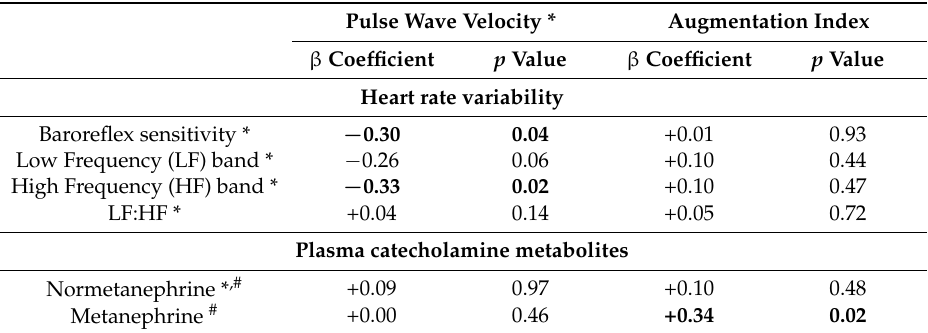
Table 1. Multiple regression analyses of the relationship between measures of autonomic nervous system activity and arterial stiffness in 47